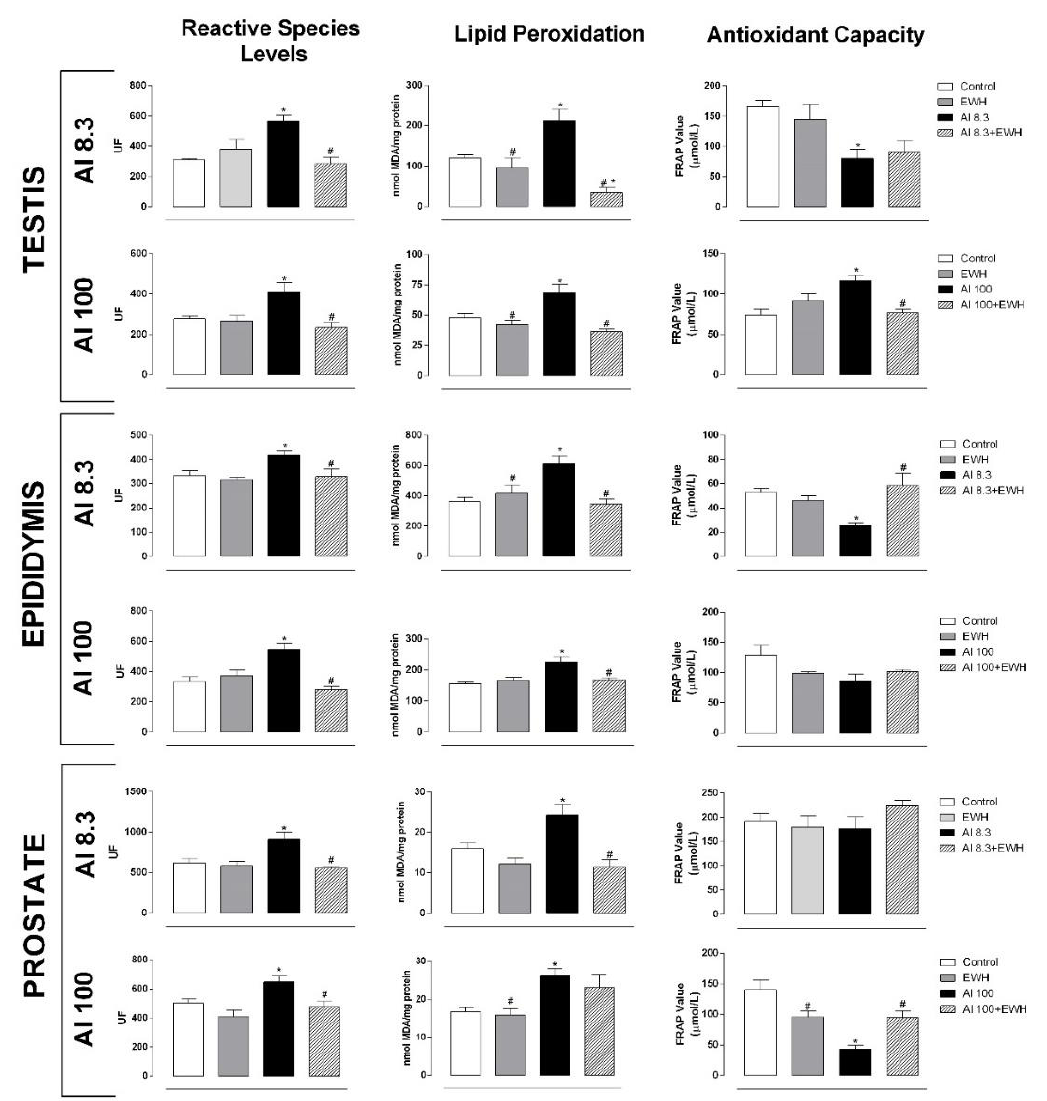
Figure 2. Effect of EWH on biochemical analysis of oxidative stress in rats exposed to AlCl 3 at 8.3 or 100 mg/Kg b.w. per day. Values of reactive oxygen and nitrogen species, lipid peroxidation and total antioxidant capacity on testis, epididymis, and prostate. UF: units of fluorescence, MDA: malondialdehyde, FRAP: ferric reducing / antioxidant power. Data are expressed as mean ± SEM, n = 8, * p < 0.05 compared with their corresponding controls, # p < 0.05 compared with AlCl 3 group (two-way ANOVA and Bonferroni as post-hoc test).